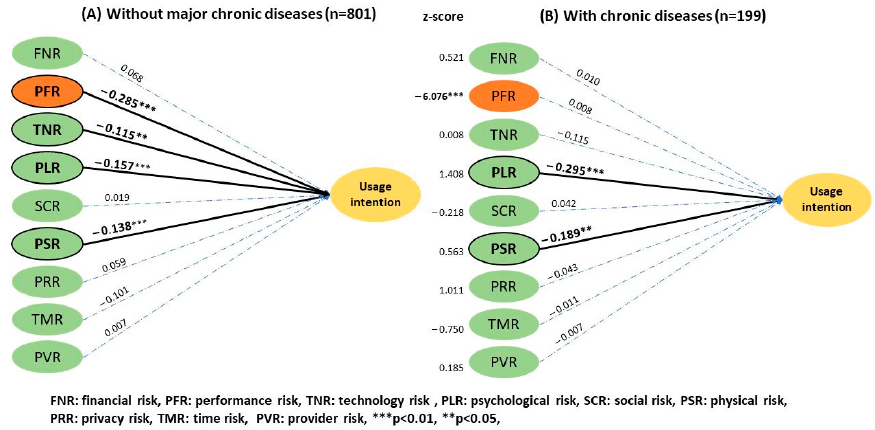
Figure 9. Results of the two-group structural model of health condition.